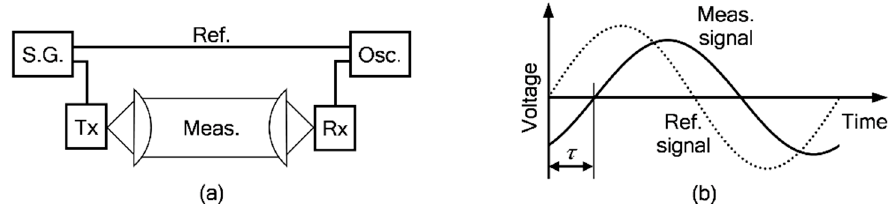
Figure 1. ( a ) Schematic of a propagation time difference measurement setup. S.G. = signal generator. Osc. = oscilloscope. Ref. = cable carrying the reference signal. Meas. = the measurement arm, consisting both of cables and free-space propagation. Tx = transmitter. Rx = receiver. ( b ) Time delay measurement.